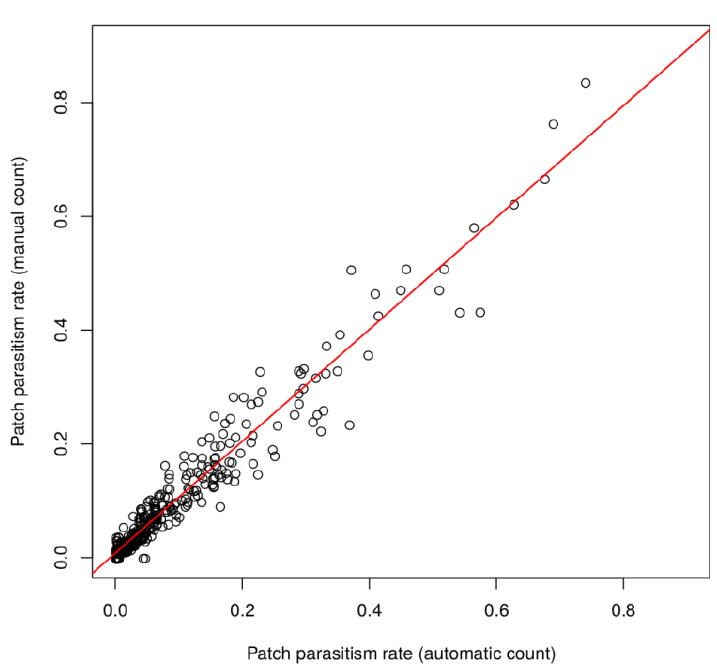
Figure S1. Correlation between automatic and manual estimates of patch parasitism rates. A subset of 400 experimental patches (200 from population acjy144, and 200 from pr002, both in “H” treatments) were manually counted. The parasitism rates obtained from the automatic counts (x-axis) and those from the automatic count (y-axis) are very closely related. The slope of the linear regression model shown in red is 0.983, its intercept is 0.008, and the coefficient of determination r 2 is 95%. For comparison, 40 patches (20 from each population) were also manually counted by two different operators: the linear regression between the two sets of manual counts had slope 1.03, intercept -0.07, and r 2 =99%.